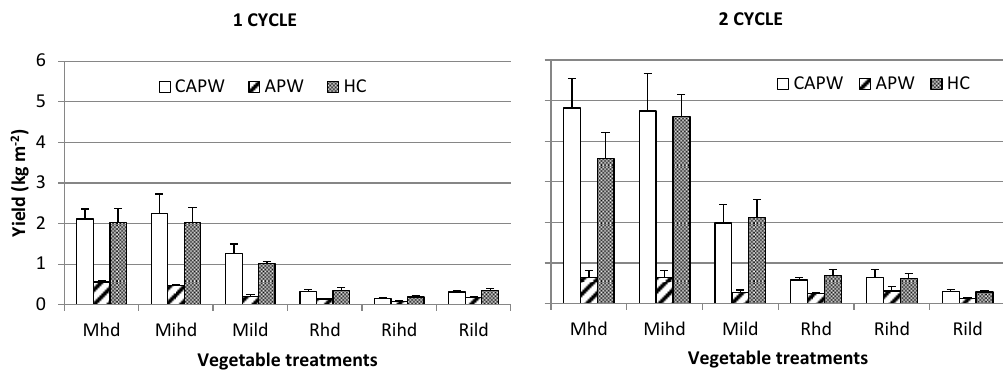
Figure 9. Effect of vegetable treatments and nutrient solutions on yields from two growth cycles. M HD : mizuna high density; M IHD : mizuna intercropped high density; M ILD : Mizuna intercropped low density; R HD : rocket salad high density; R IHD : rocket salad intercropped high density; R ILD : rocket salad low density; HC: hydroponic control; APW: aquaponic water; CAPW: complemented aquaponic water.